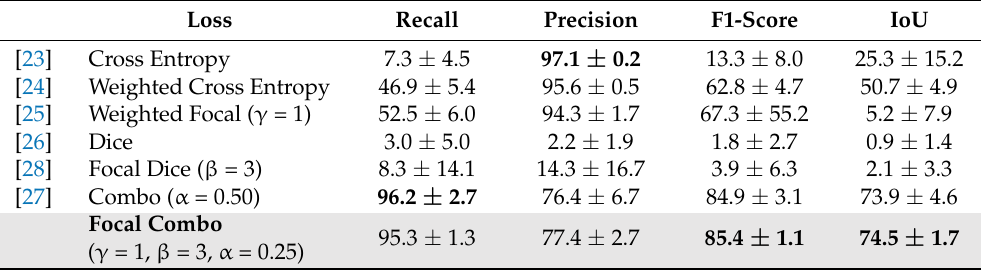
Table 4. Results after the ‘black’ pixel omission for U-Net in (%) for the road marking class. Loss Recall